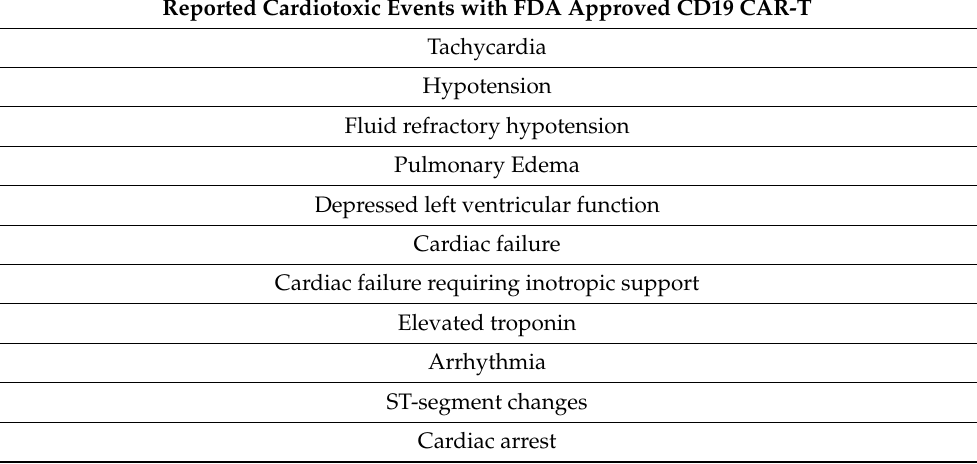
Table 2. Summary of reported cardiovascular events associated with CD19-CAR-T.